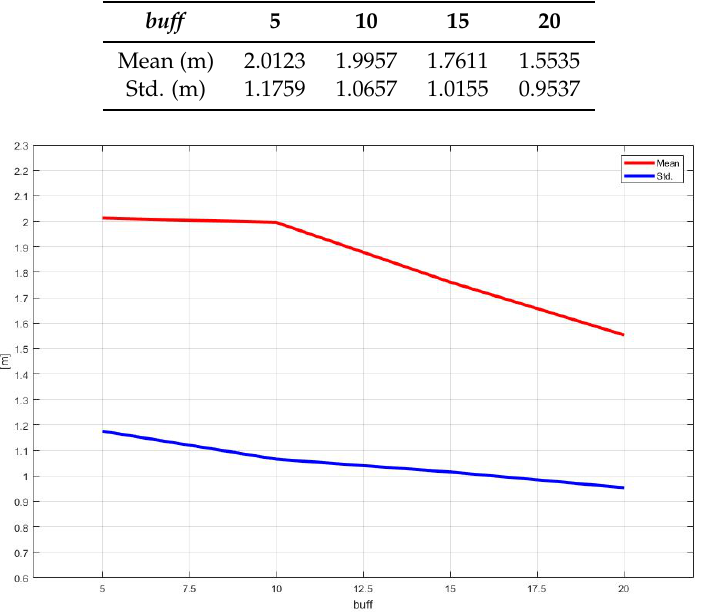
Table 4. Mean and standard deviations of Course 2 according to the size of buff .